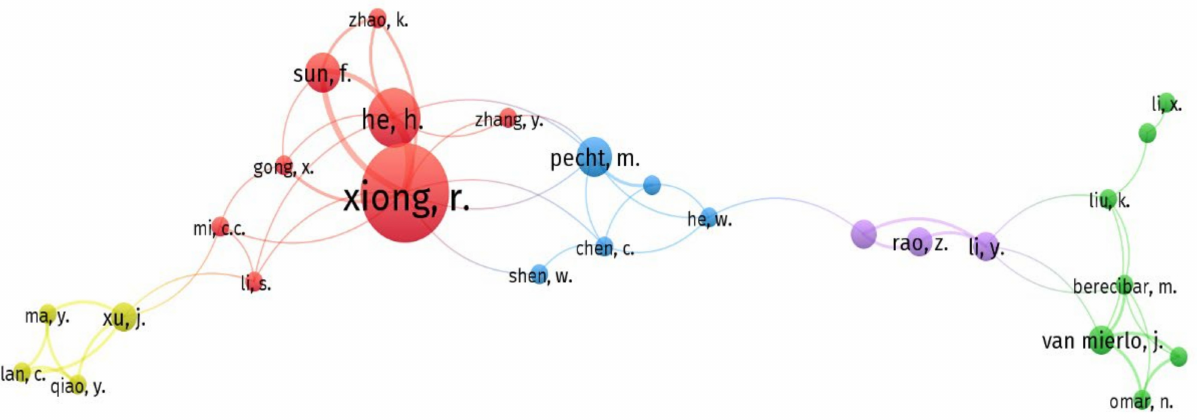
Figure 10. Co-authorship analysis of the selected most cited articles in the field of BMS technology for EV